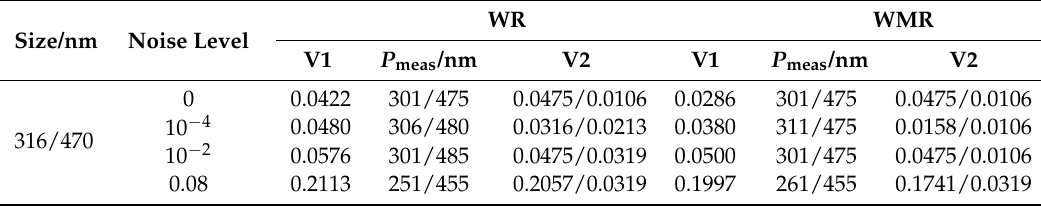
Table 2. The performance indices of the inversion for simulated 466/915 nm bimodal DLS data under Table 3. The performance indices of the inversion for simulated 316/470 nm bimodal DLS data under different noise levels. different noise